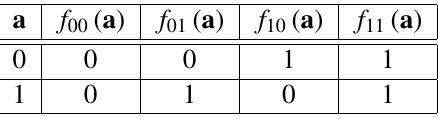
Table 1: Tabular representation of the functions f b ( a ) that are evaluated by the black box in the Deutsch’s